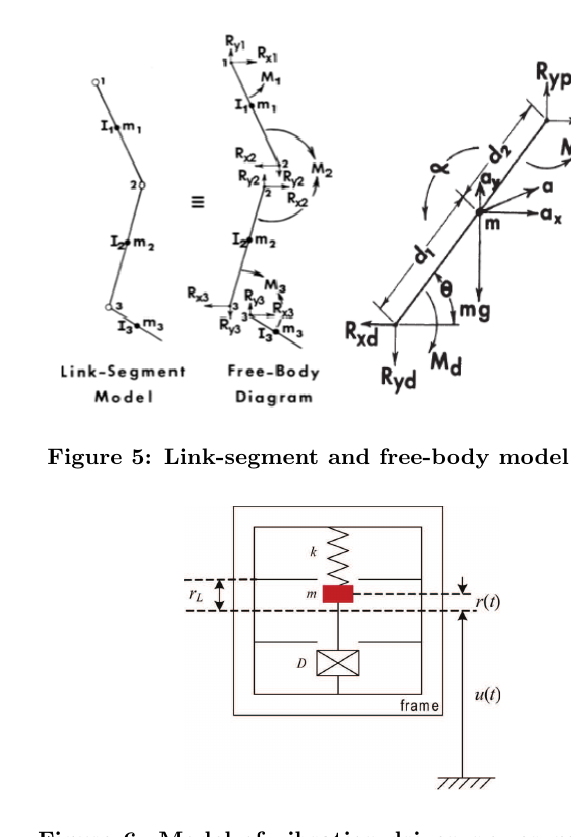
Figure 6: Model of vibration-driven power genera- tor [12,